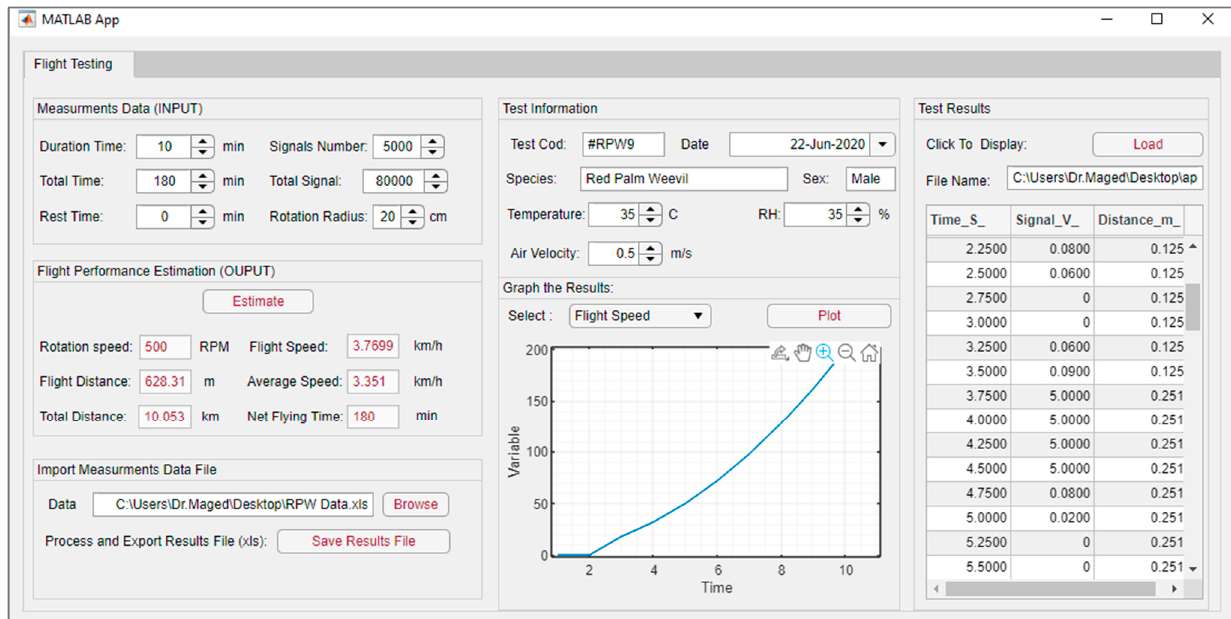
Figure 16. Ambient RH, inside RH of the testing chamber, compared to the minimum and maxi- mum set points of 34.5 and 35.5% to obtain the target RH of 35% RH at 30 °C for 6 h.